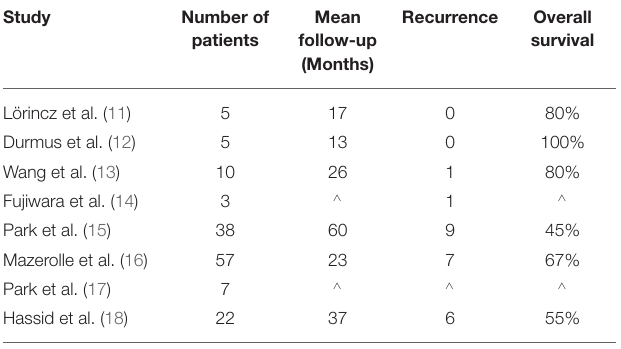
TABLE 1 | Summary of the studies involved in the systematic analysis of TORS.